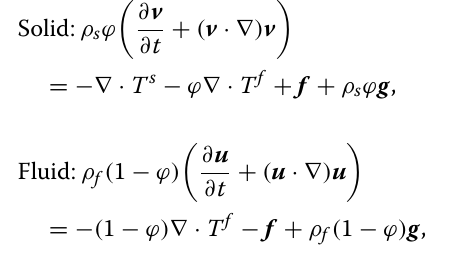
Table 1 Observed and estimated parameter values of tephra, snow, water, and time duration for lahar simulations